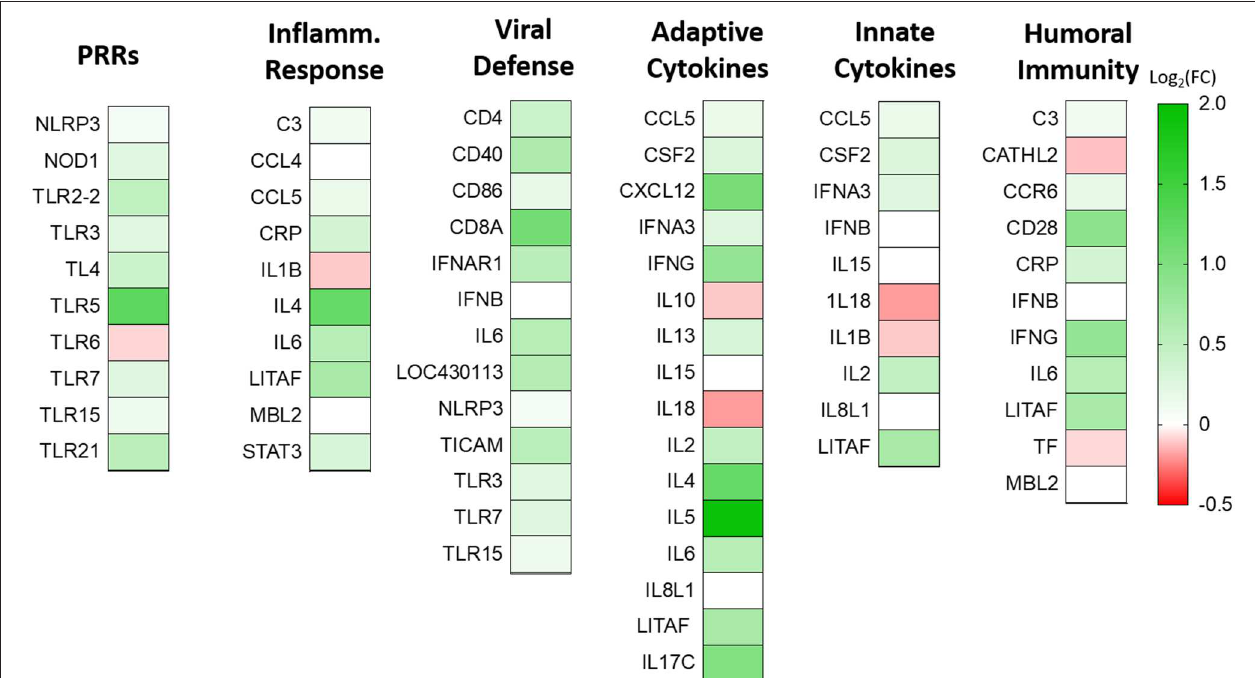
FIGURE 5 | Effect of NLRC5 KD on differentially expressed immune genes during H5N2 infection. NLRC5 siRNA and scramble control transfected MQ-NCSU cells were infected with H5N2 virus. Total RNA was collected at 24 hpi and assayed by the RT ² Profiler PCR Array system. Selected genes taking part in innate and adaptive immune response are shown as log 2 transform of fold-change expression relative to the gene expression in the mock-transfected cells. Data represent an average of three biological replicates.